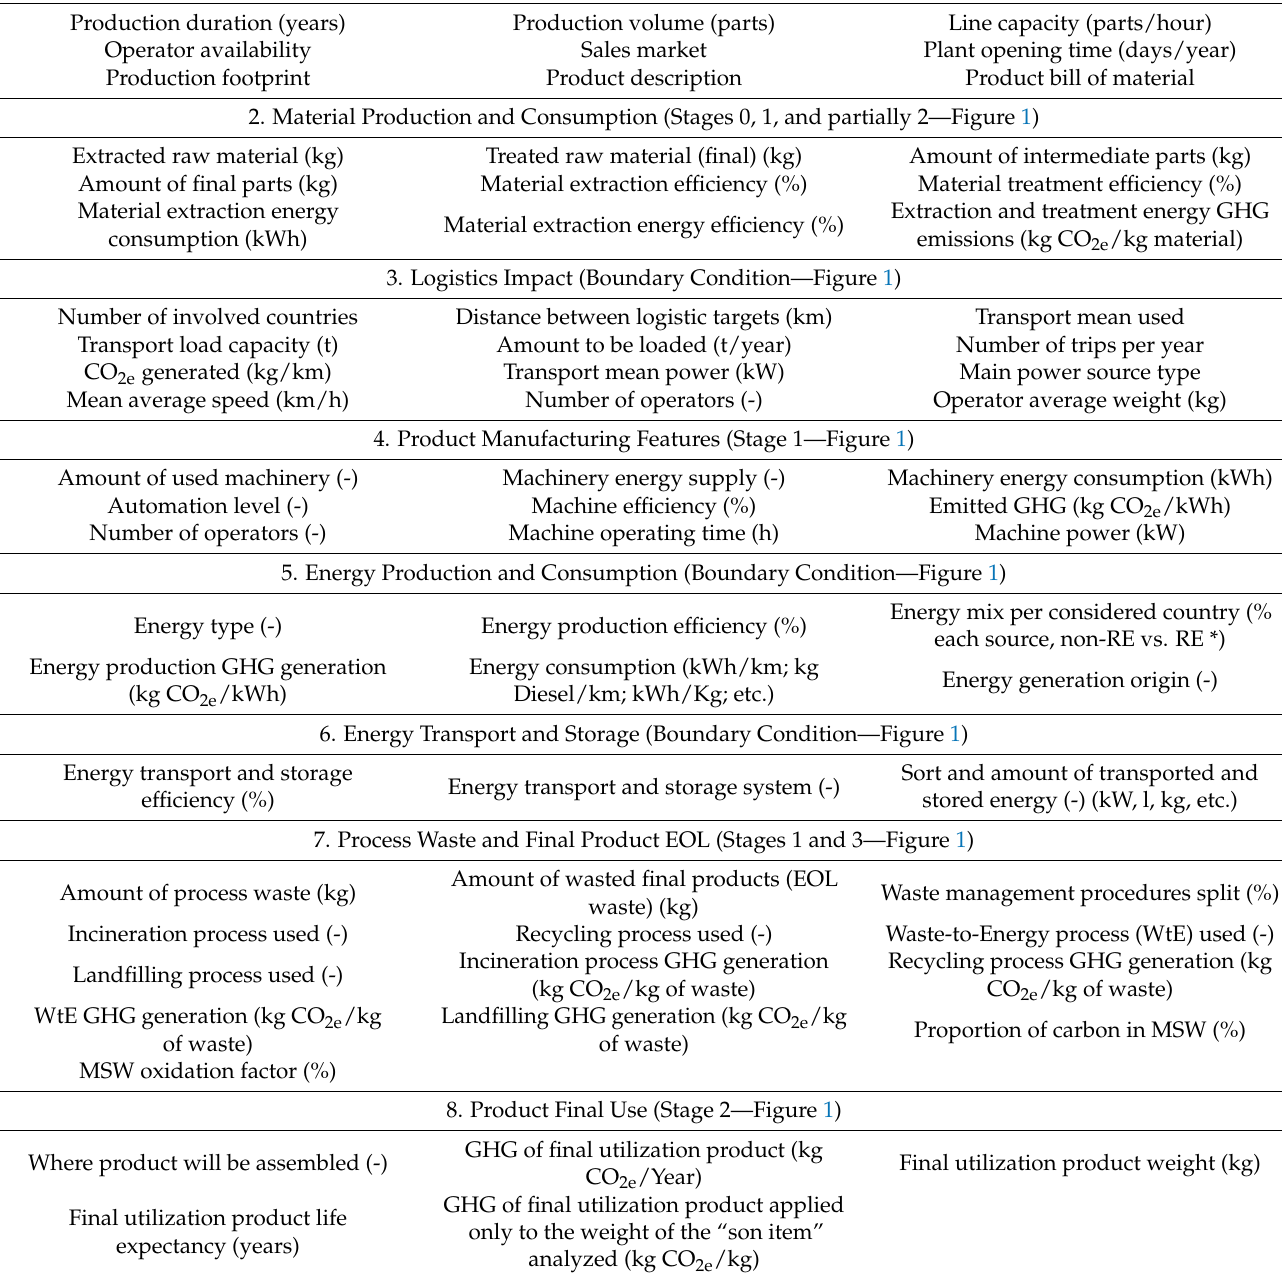
Table 1. Crucial information to create the life cycle inventory. Linked to Figure 1. 1. General Features (Stages 0 and 1—Figure